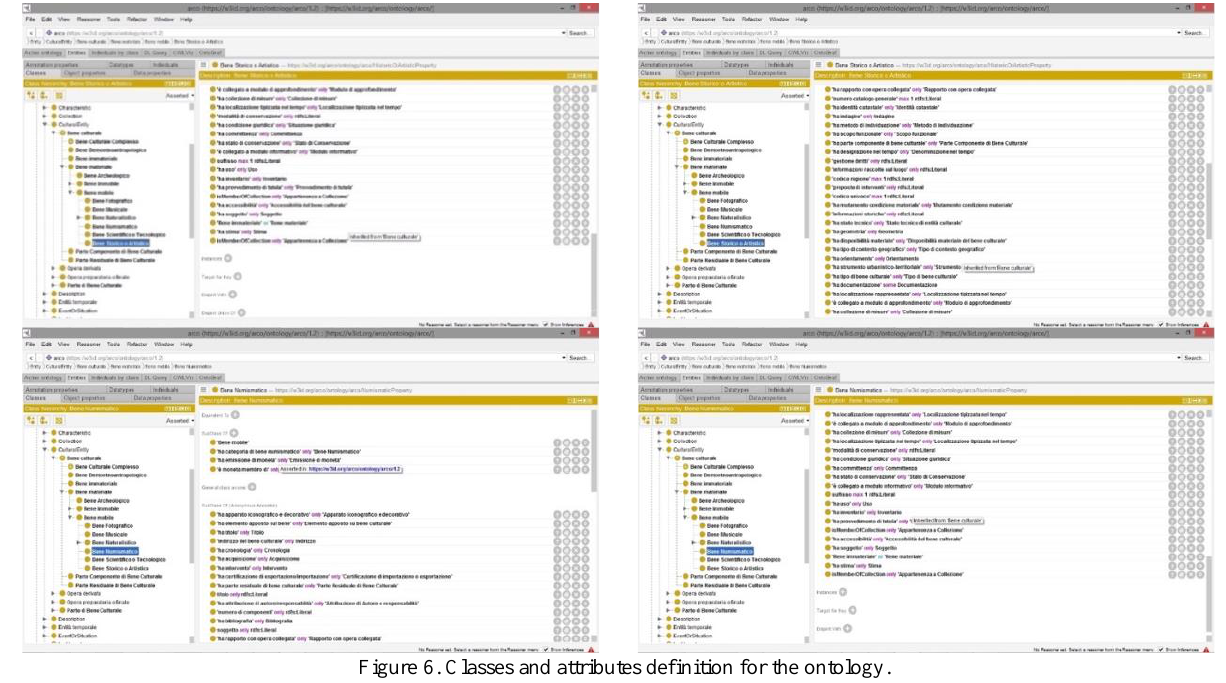
Figure 6. Classes and attributes definition for the ontology.